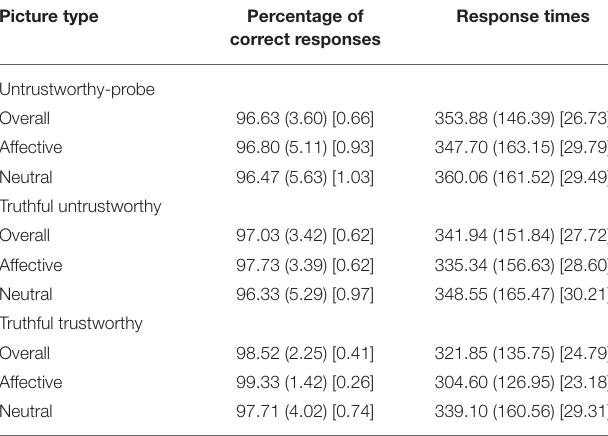
TABLE 4 | Percentage of correct responses (%) and mean response times (ms) in correct